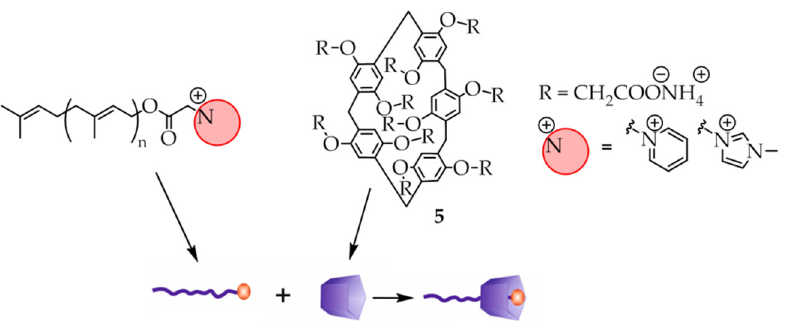
Figure 1. The concept of a supramolecular amphiphiles based on pillar[5]arene 5 and amphiphilic meroterpenoids.